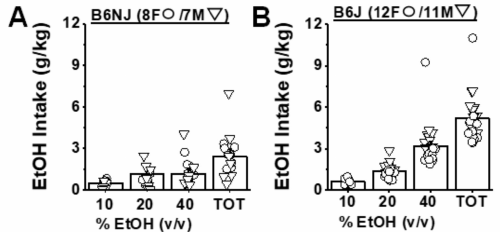
Figure 2. Baseline alcohol intake under 3-bottle-choice procedures in B6NJ and B6J mice. Summary of the dose–response function for alcohol (EtOH) intake and the total (TOT) alcohol intake of female (F) and male (M) ( A ) B6NJ and ( B ) B6J mice prior to A33 testing. The data represent the mean ± SEM of the number of mice indicated in each panel, in addition to the individual data points for each concentration and total